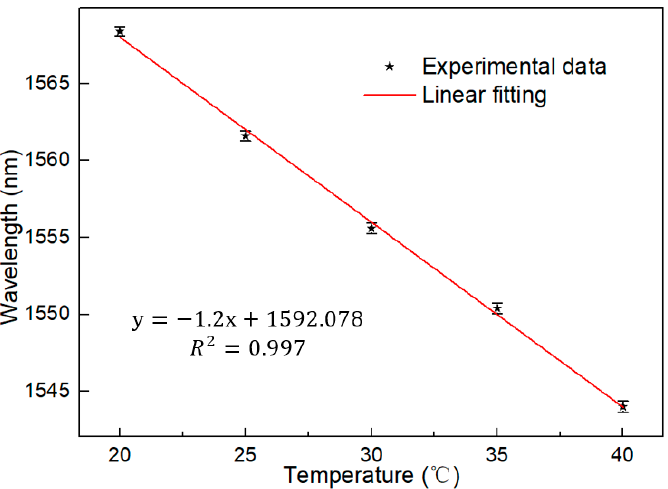
Figure 13. Linear fitting curve of laser changes with temperature (20 °C–40 °C; interval is 5 °C).